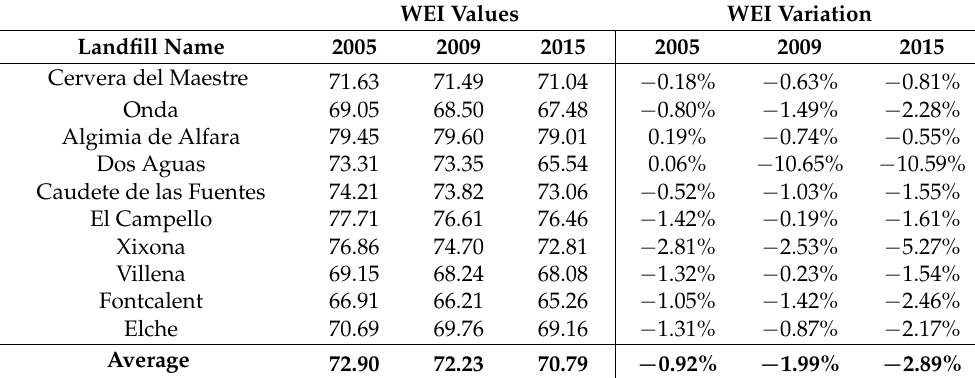
Table 4. WEI values and percentage variation over time in the 2005–2009–2015